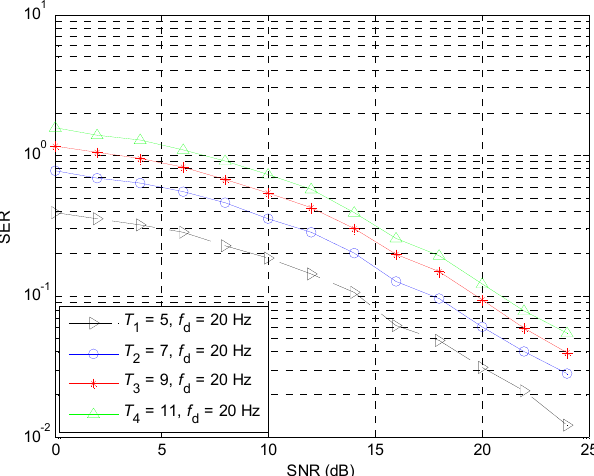
Figure 7. SER performances of the 16 QAM-modulated CP-OFDM system over Brazil D with a Doppler spread of 20 Hz.